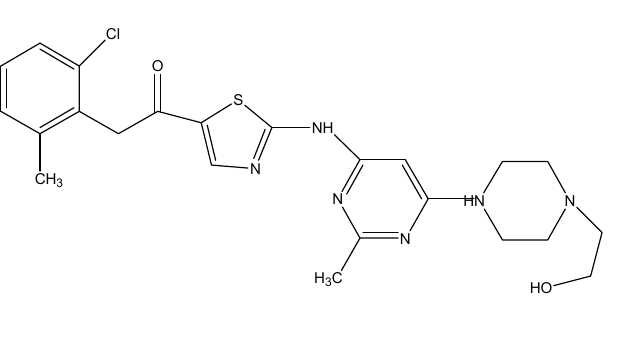
Figure 5. Structure of